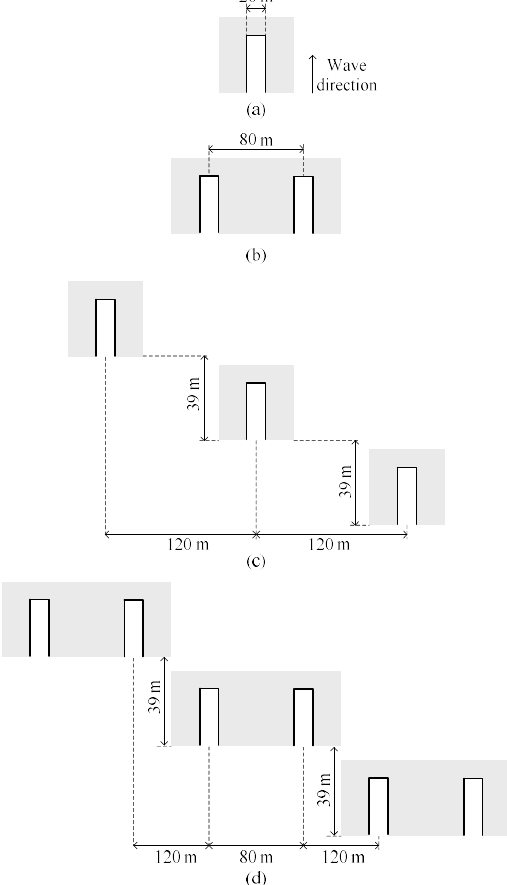
Figure 1. Vented oscillating water column (VOWC) wave energy converter layouts: ( a ) single VOWC, ( b ) two VOWC devices with three times spacing, ( c ) array of three individual VOWCs in the nearshore detached breakwater (VOWCDBW), ( d ) hybrid array of VOWCs in the VOWCDBW.